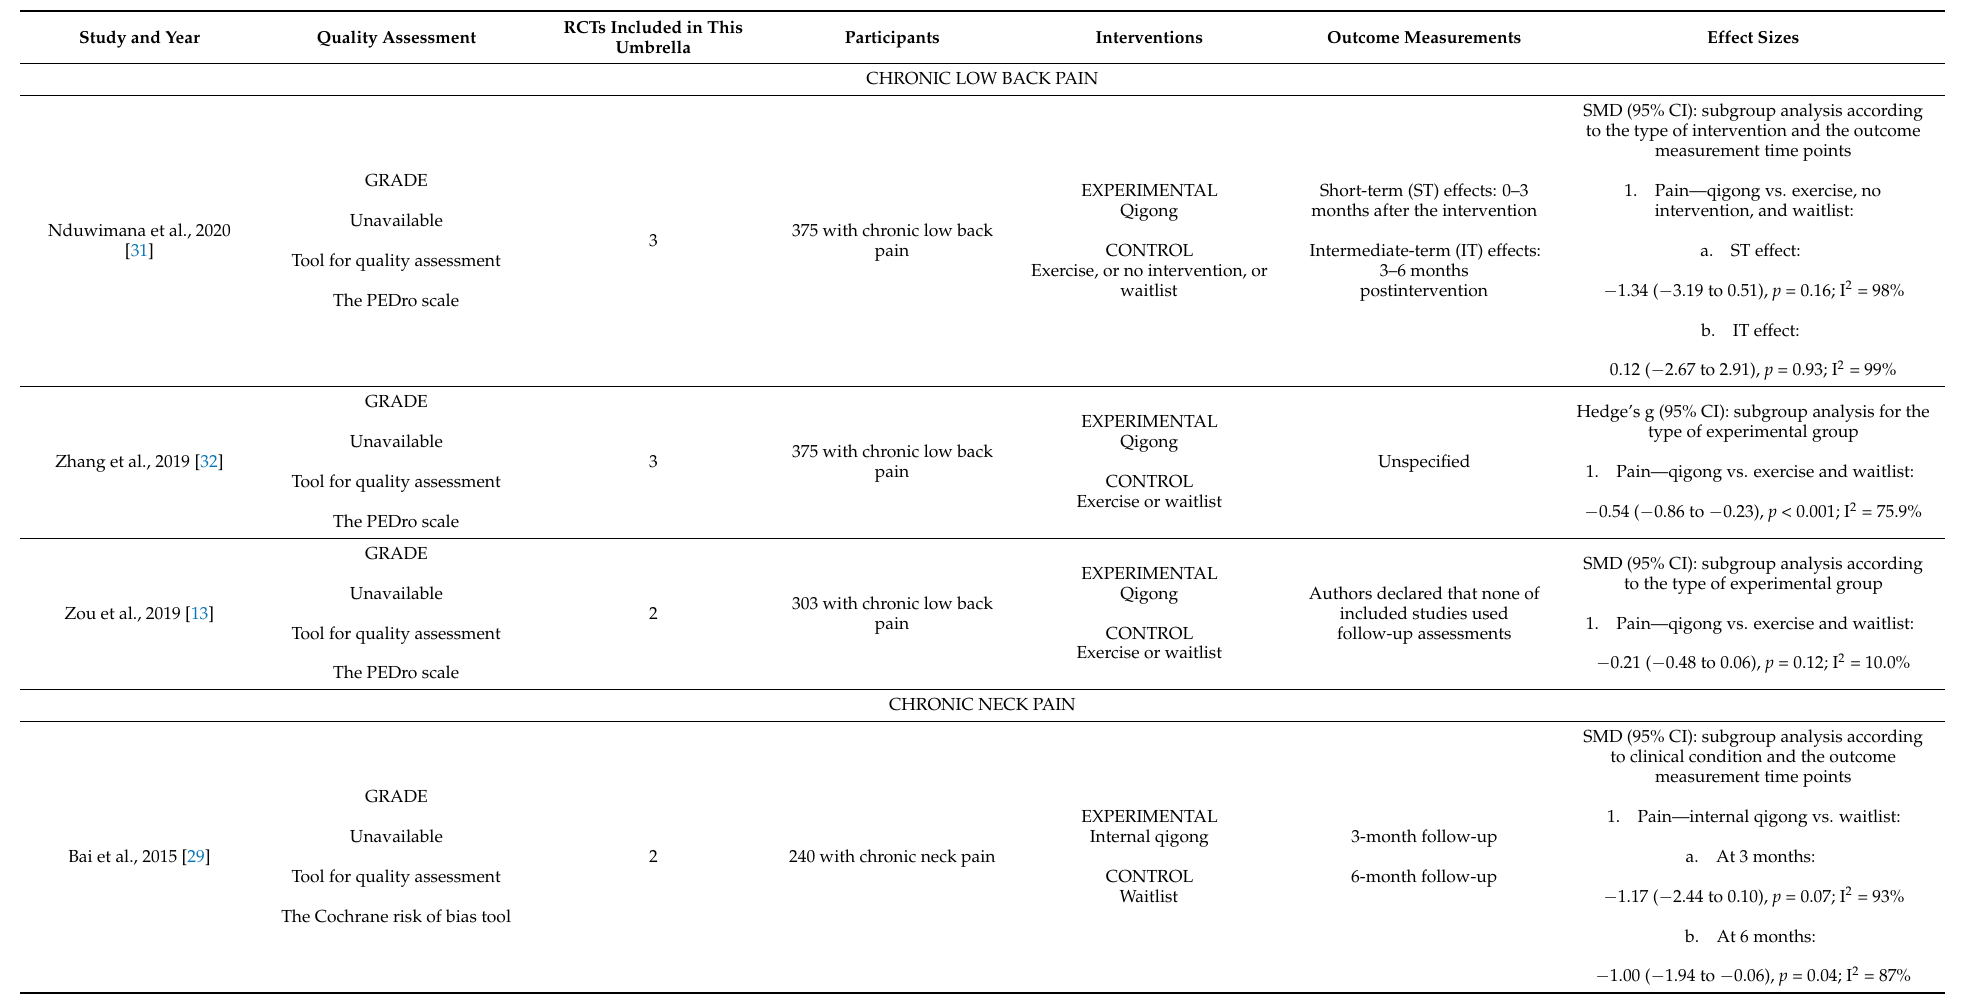
Table 2. Included reviews: